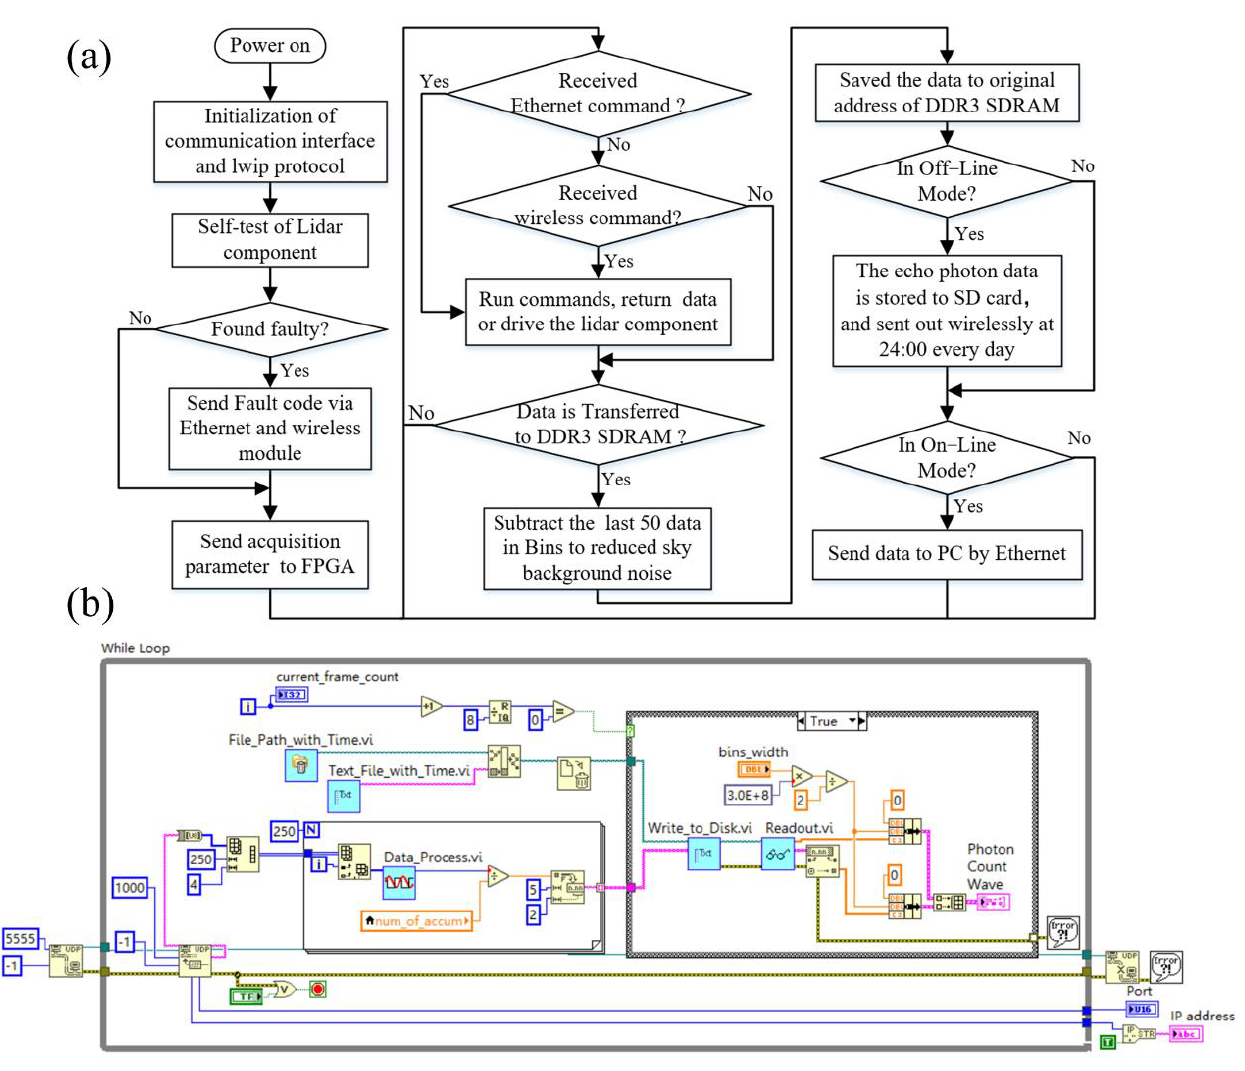
Figure 9. Software design: ( a ) embedded program flow chart; ( b ) the main program of the upper computer.